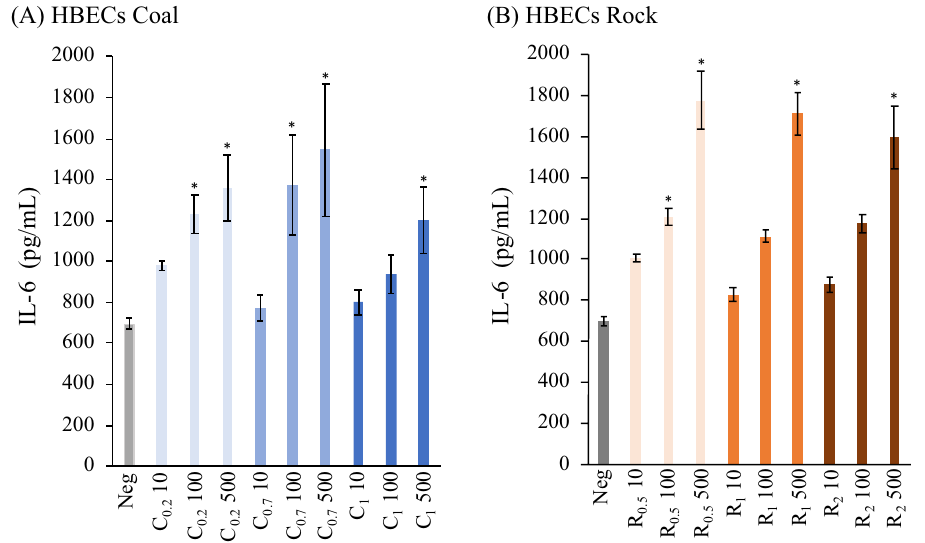
Figure 7. Inflammatory cytokines expressions (IL-6) for HBECs of various ( A ) coal and ( B ) rock dust treatment (10, 100, 500 µg/ml) ( p < 0.05*).